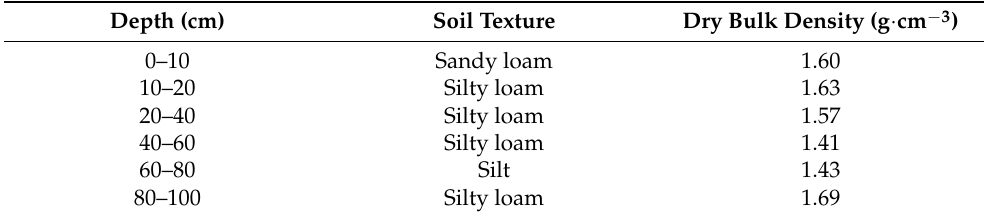
Table 1. Soil texture of experimental sites.